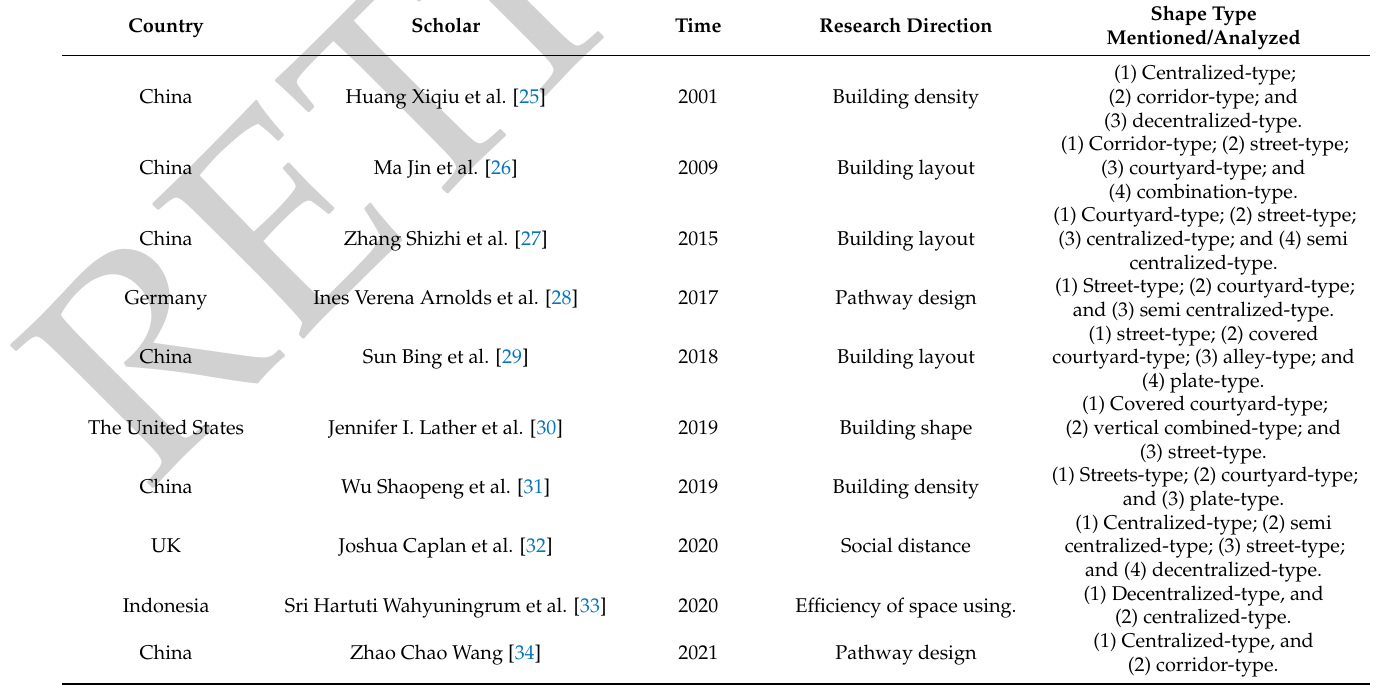
Table 1. Literature review of outpatient building research.